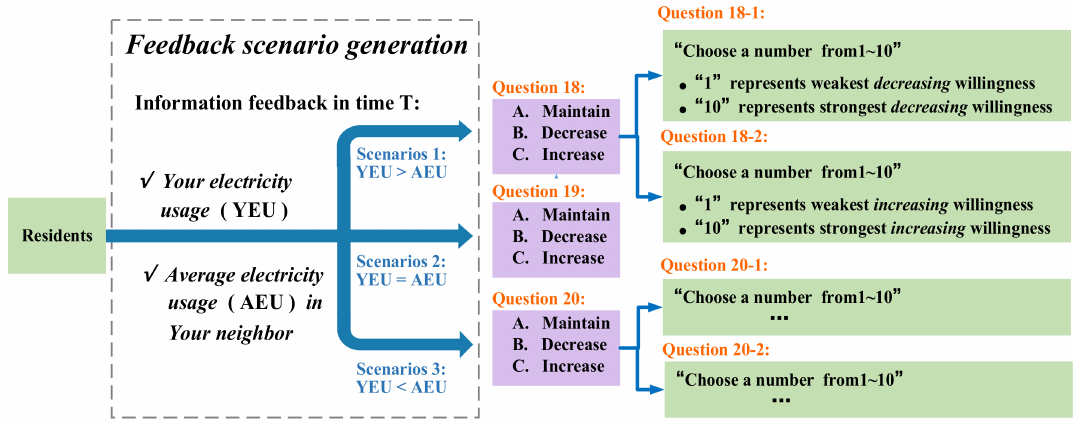
Figure 2. The sketch map of feedback scenario